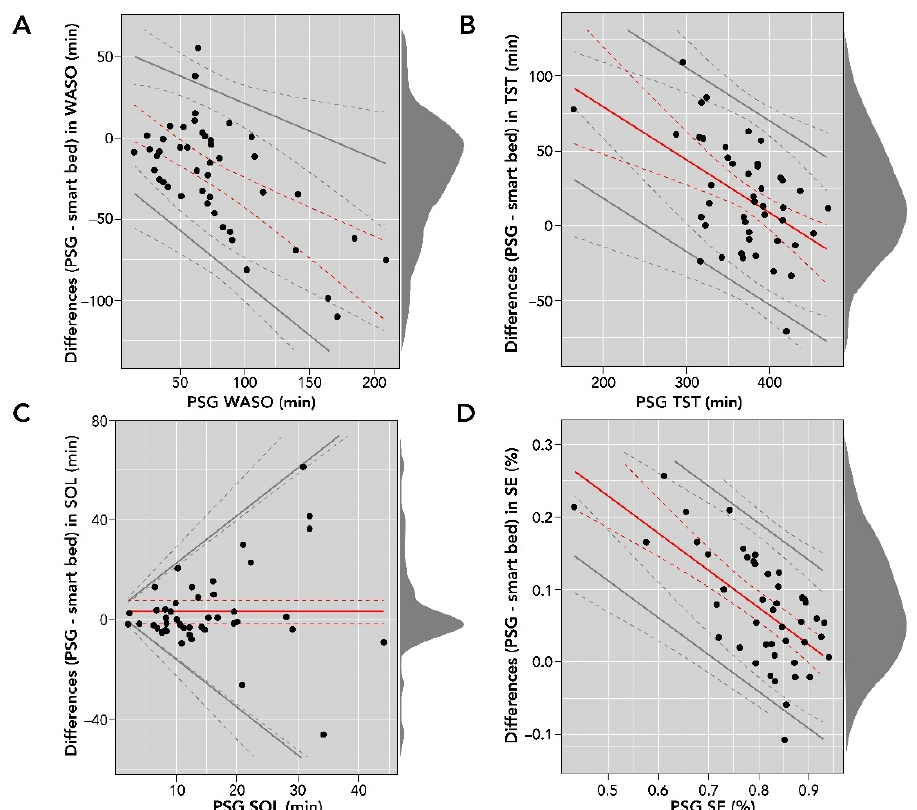
Figure 5. Bland–Altman comparisons of smart bed- versus PSG-derived WASO ( A ); TST ( B ); SOL ( C ); and SE ( D ). The density diagram on the right side of each plot represents the distribution of the differences for each variable. The solid lines are the bias and LOA. The dotted lines represent the cor- responding confidence intervals for bias and LOA. LOA, level of agreement; PSG, polysomnography; SE, sleep efficiency; SOL, sleep onset latency; TST, total sleep time; WASO, wake after sleep